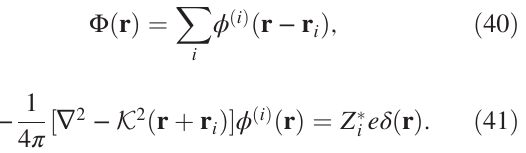
FIG. 3. Convergence of K . Convergence of the screening function K ð z Þ with increasing number of bins. Profiles of K ð z Þ are shown in the top row, while convergence of the solution is presented in the bottom row in terms of the relative error E K is the converged function, and k f ð z Þk ≡ c details), where the left column is the initial ( t ¼ 0 ps) sharp interface and the right column is a late-time ( t ¼ 15 ps) diffuse